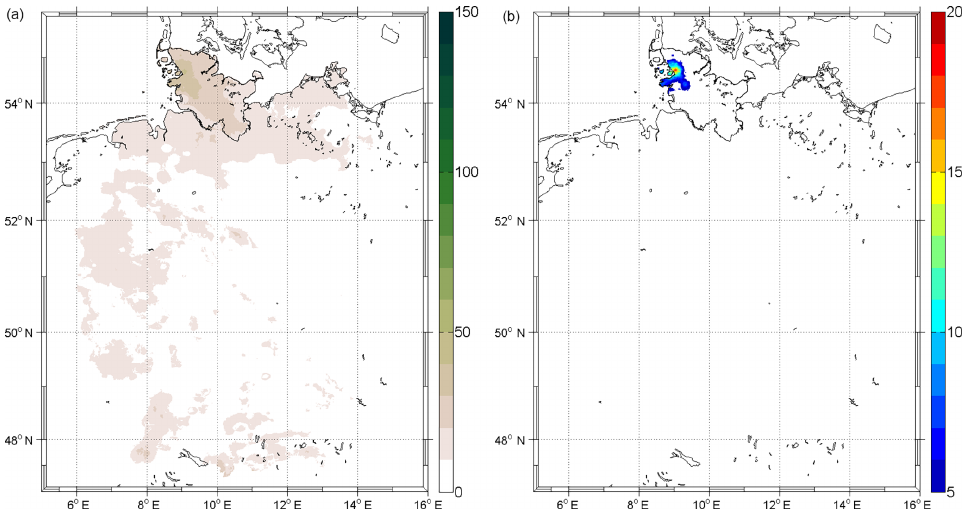
Figure 8. As in Fig. 7, but for the API.